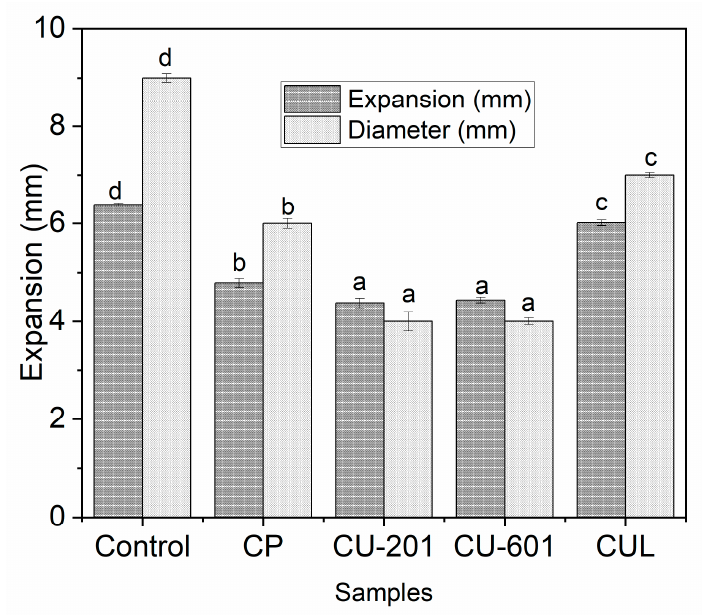
Figure 2. Expansion and changes in diameters of cookies dough prepared with pectin with different molecular structure and molecular weight. CUL, CP, CU-601, and CU-201 indicate the names of pectin which were added in cookies. Reported graphs are the mean of triplicates for each treatment. Small letters over error bars represent the significant difference between treatments at a level of p < 0.05 using one-way ANOVA and Duncan multiple range test.